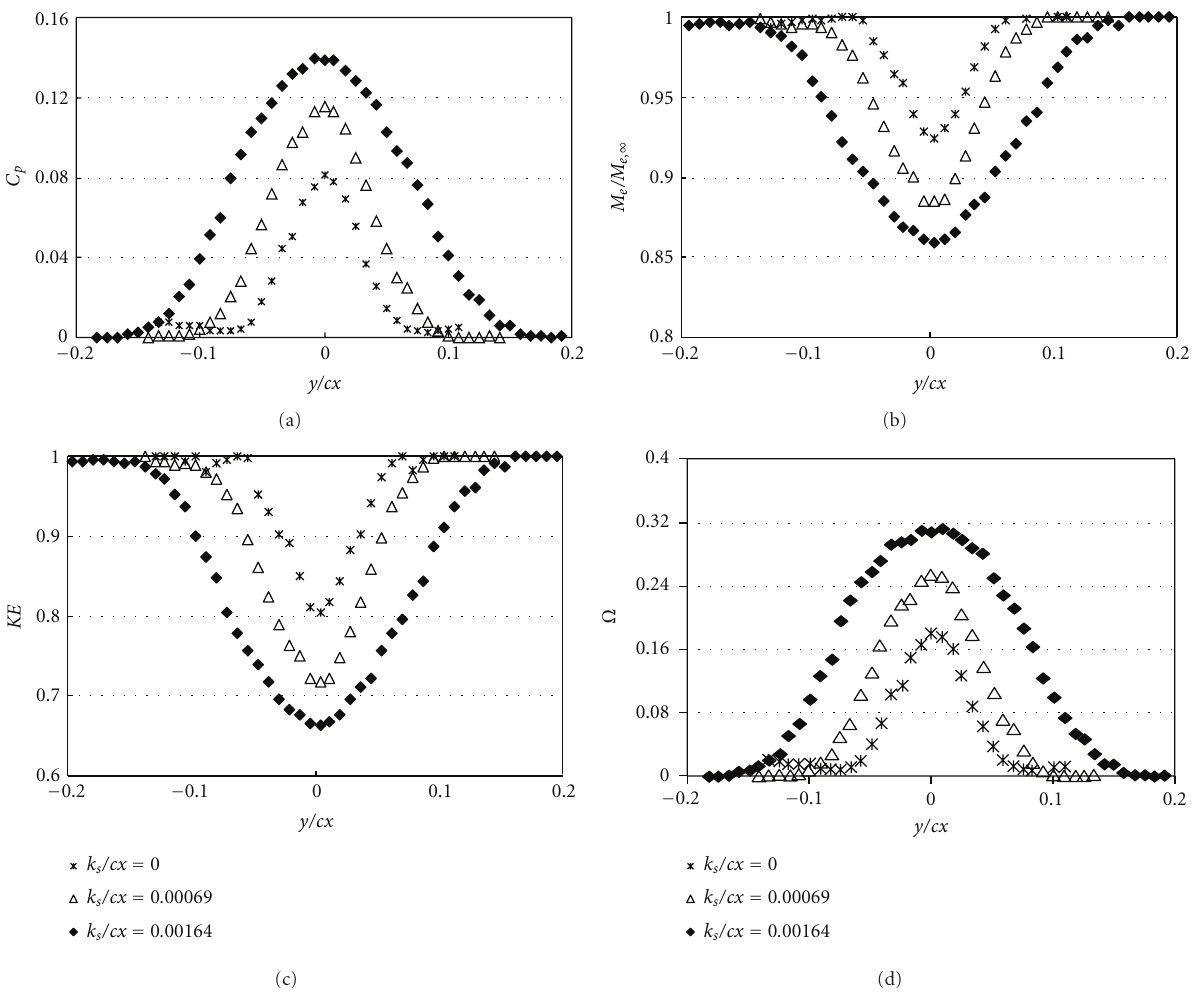
Figure 5: Profiles measured with M e , ∞ = 0 . 9 and Tu = 0 . 9% for the symmetric airfoil [8]. (a) Normalized local total pressure losses. (b) Normalized local Mach numbers. (c) Normalized local kinetic energy. (d) Ω total pressure loss coe ffi